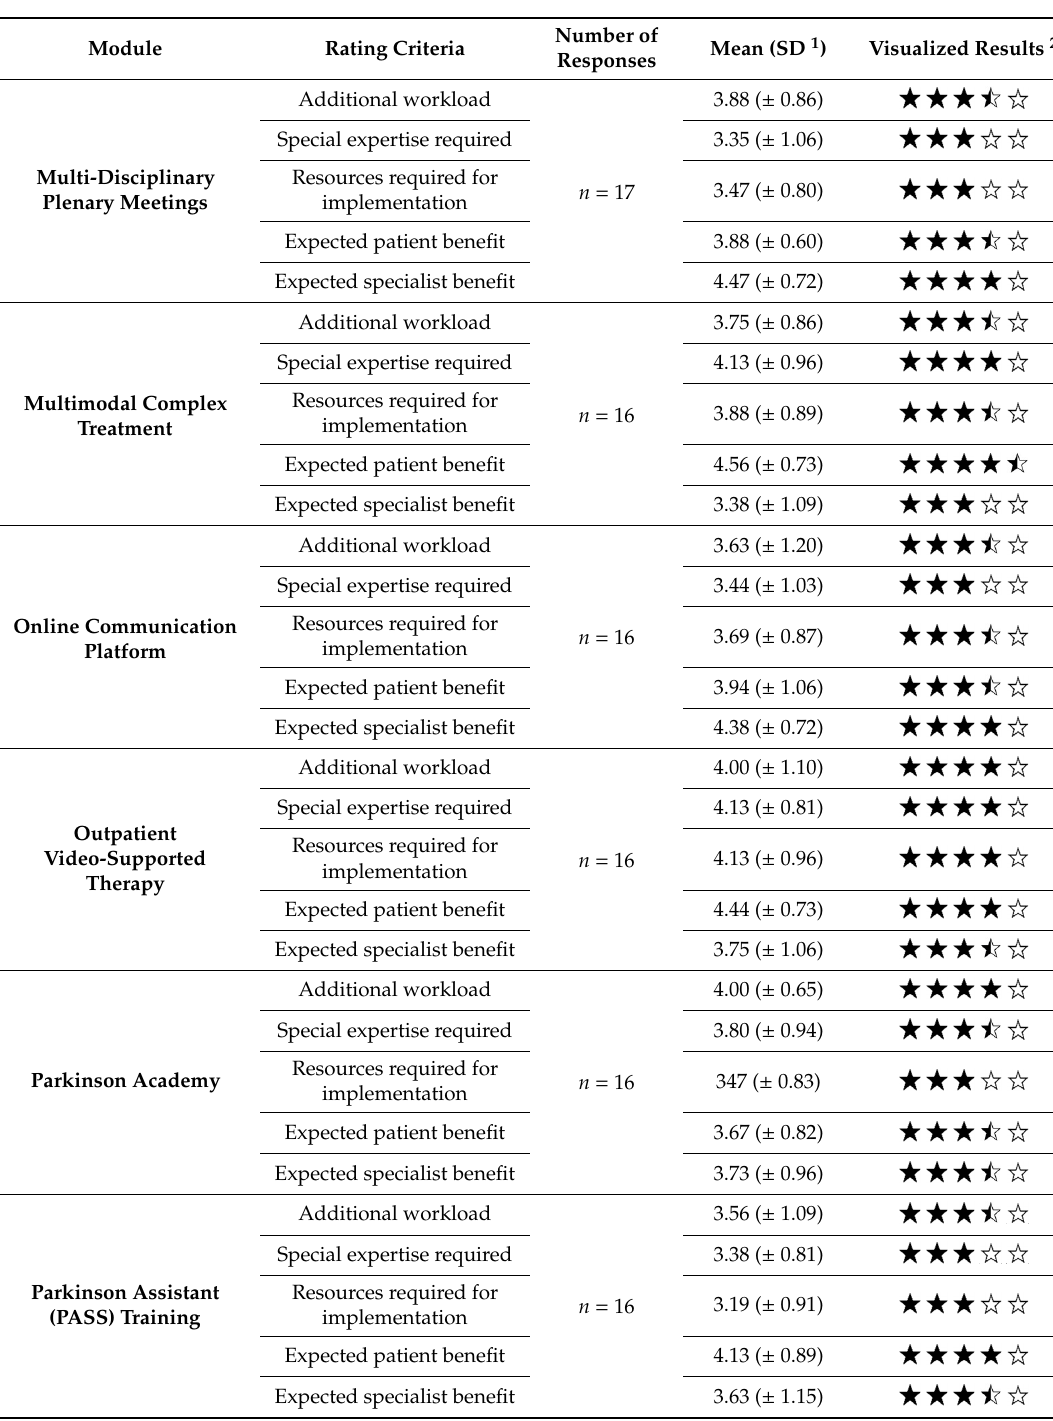
Figure 3. Box Plots for the Rating Categories and Rating Values (Modules: n = 25, Raters: n = 17) .